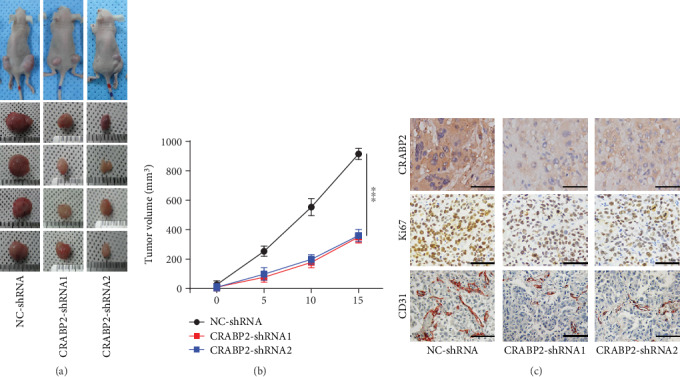
Effects of CRABP2 on tumor growth in vivo. HpeG2 cells transfected with two different CRABP2-shRNA were injected into nude mice (n = 13 for each group). Representative images of tumors dissected from mice are shown in (a), and tumor volume (b) was measured every other 5 days. Representative images of CRABP2, Ki-67, CD31 staining after immunohistochemistry are shown in (c). Scale bar = 100 μm. One-way ANOVA was used in multigroup comparison. All data are presented as mean ± SEM. ∗∗∗P < 0.001 vs. NC-shRNA.